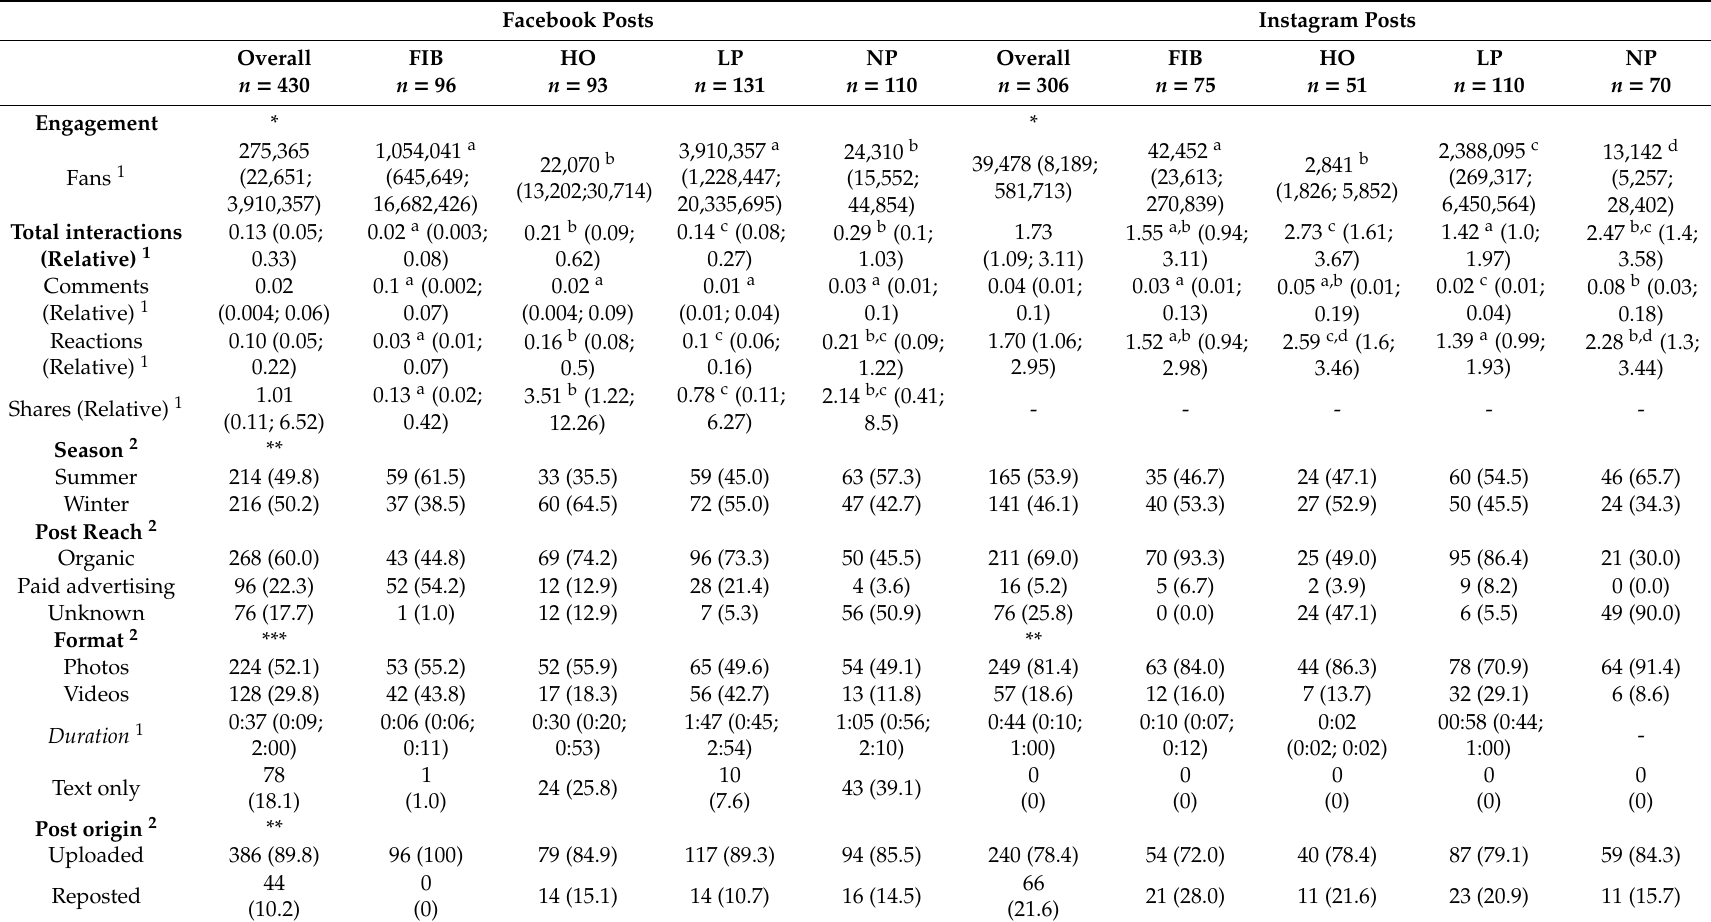
Table 1. Engagement and format metrics by platform and